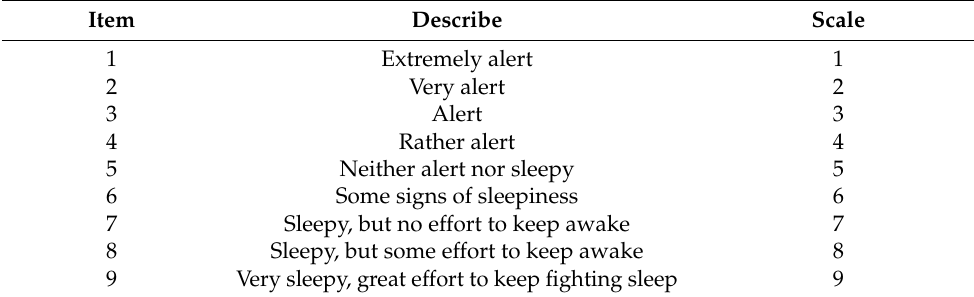
Table 2. Description of Karolinska sleepiness scale. Data from [28].